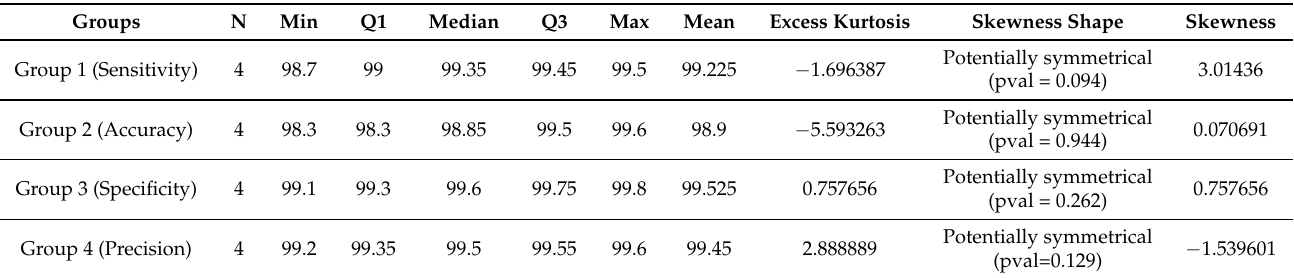
Table 5. The parametric representation for the understanding of the boxplots and overall behaviour of the